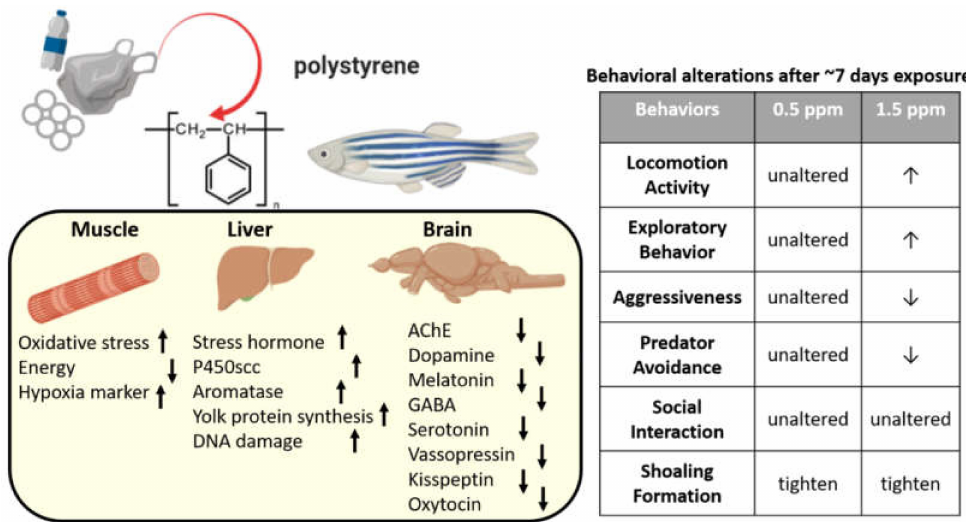
Figure 9. Schematic diagram of the biochemical and behavioral changes after polystyrene nanoplastics (PS-NPs) exposure in zebrafish. Left panel showing the biomarker expression alteration ( ↑ : up regulated, ↓ : down regulated) in the muscle, liver, and brain after PS-NPs exposure. Right panel showing the behavioral alteration after PS-NPs exposure at either 0.5 or 1.5 ppm ( ↑ : higher behavior level, ↓ : lower behavior